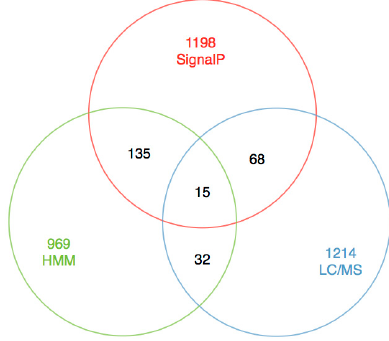
Figure 4. The statistics for SignalP, HMM search, LC-MS/MS and their mutual overlaps.